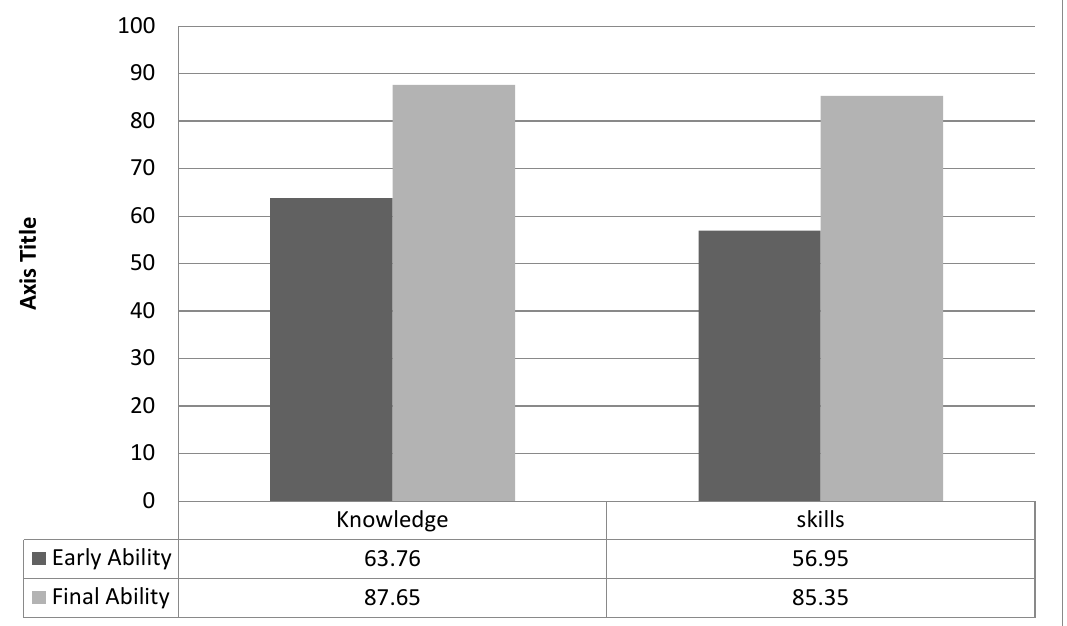
Fig. 1 of Improvement of teacher knowledge and